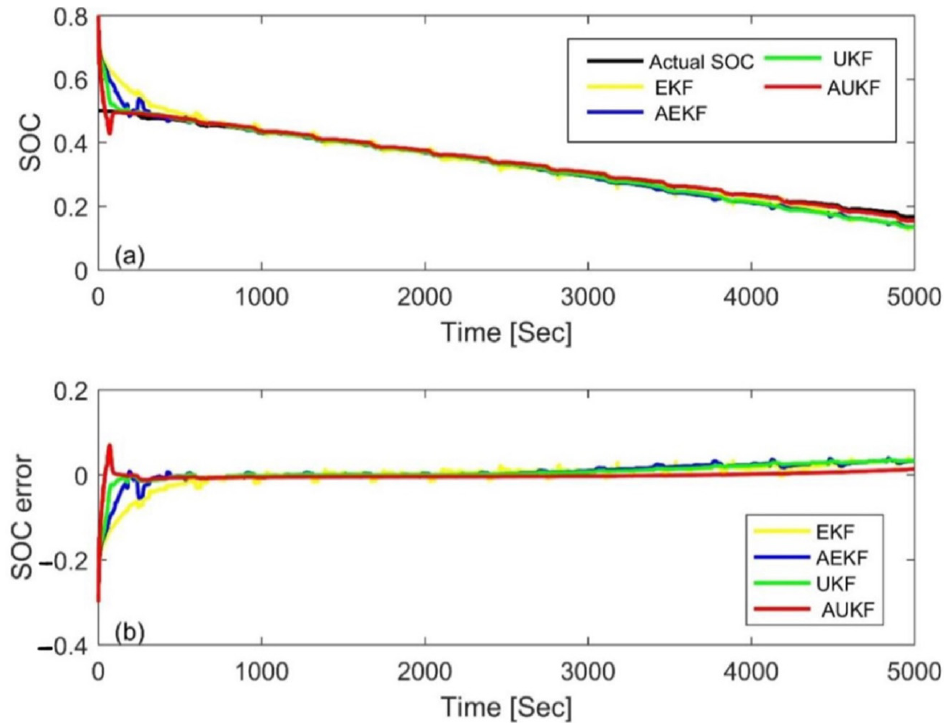
Figure 16. Estimation results at an initial SOC of 80% via the DST. ( a ) SOC estimation comparison curve; ( b ) SOC estimation error.